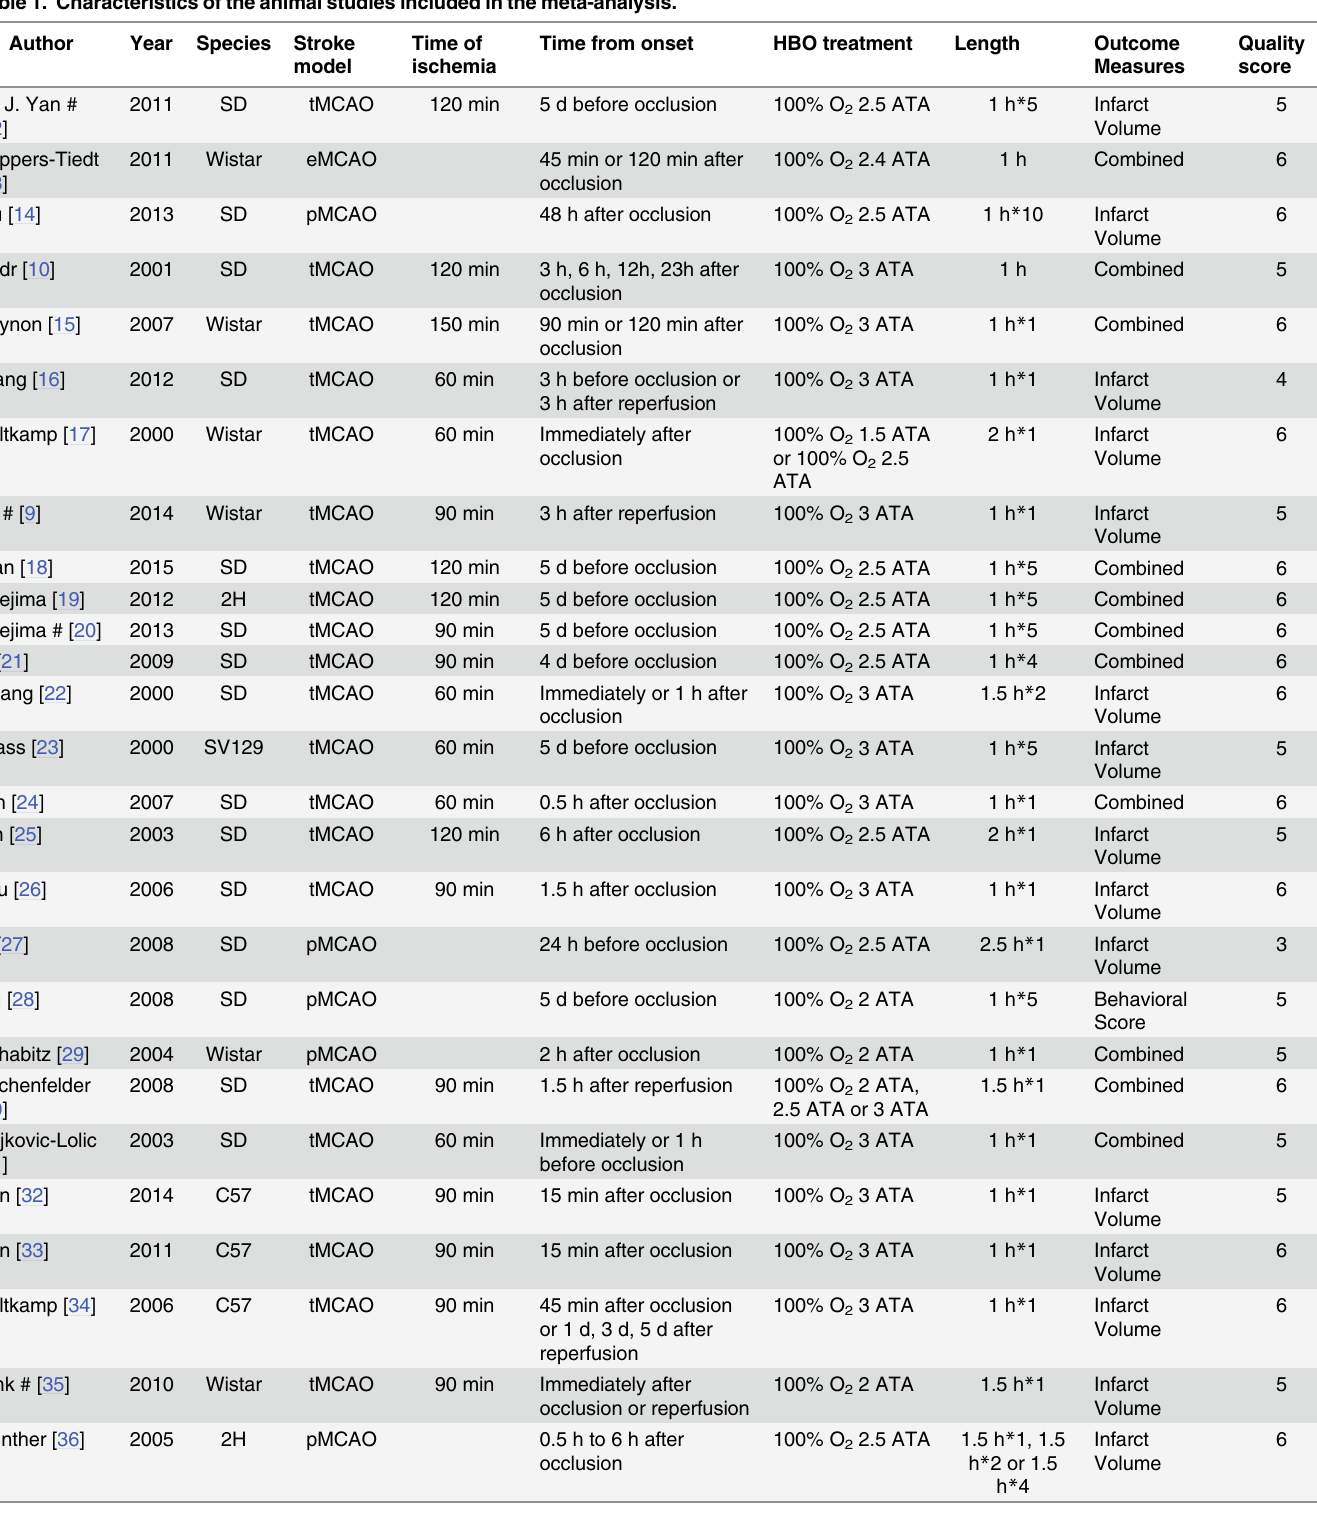
Table 1. Characteristics of the animal studies included in the